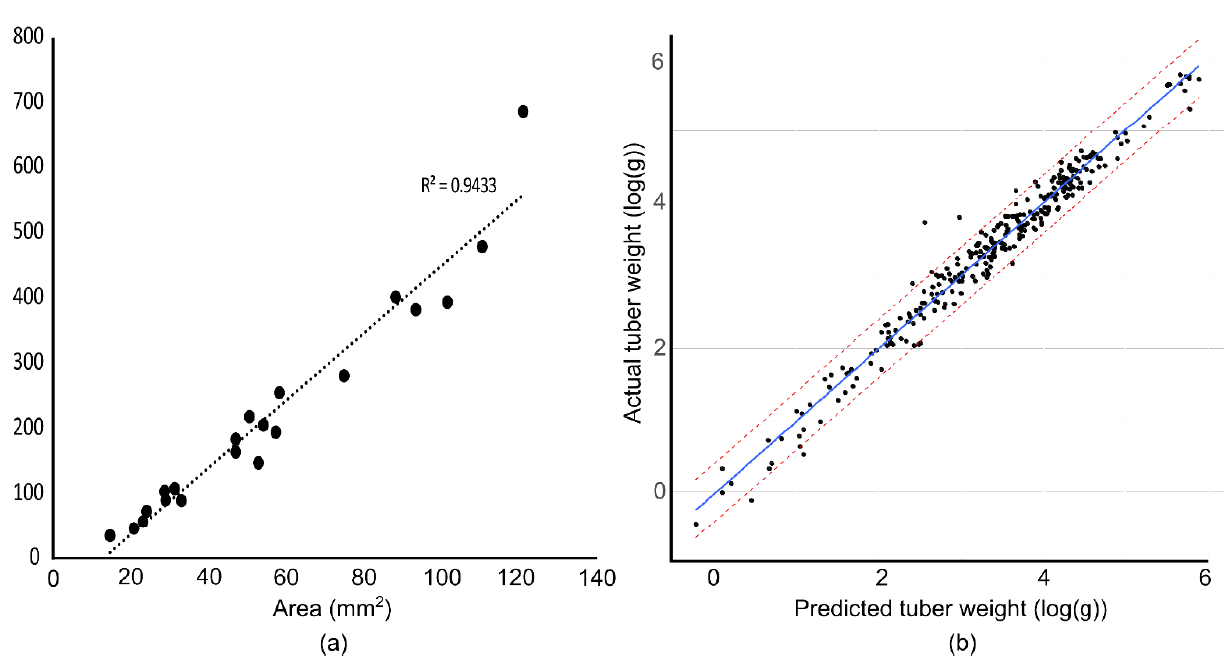
Figure 1. Tuber area vs. weight. Tuber area was calculated using ImageJ and compared to tuber weight. ( a ) individual tuber weight vs. area. ( b ) prediction model for tubers harvested from a single plant grown in the greenhouse. Dashed lines indicate 95% prediction interval.